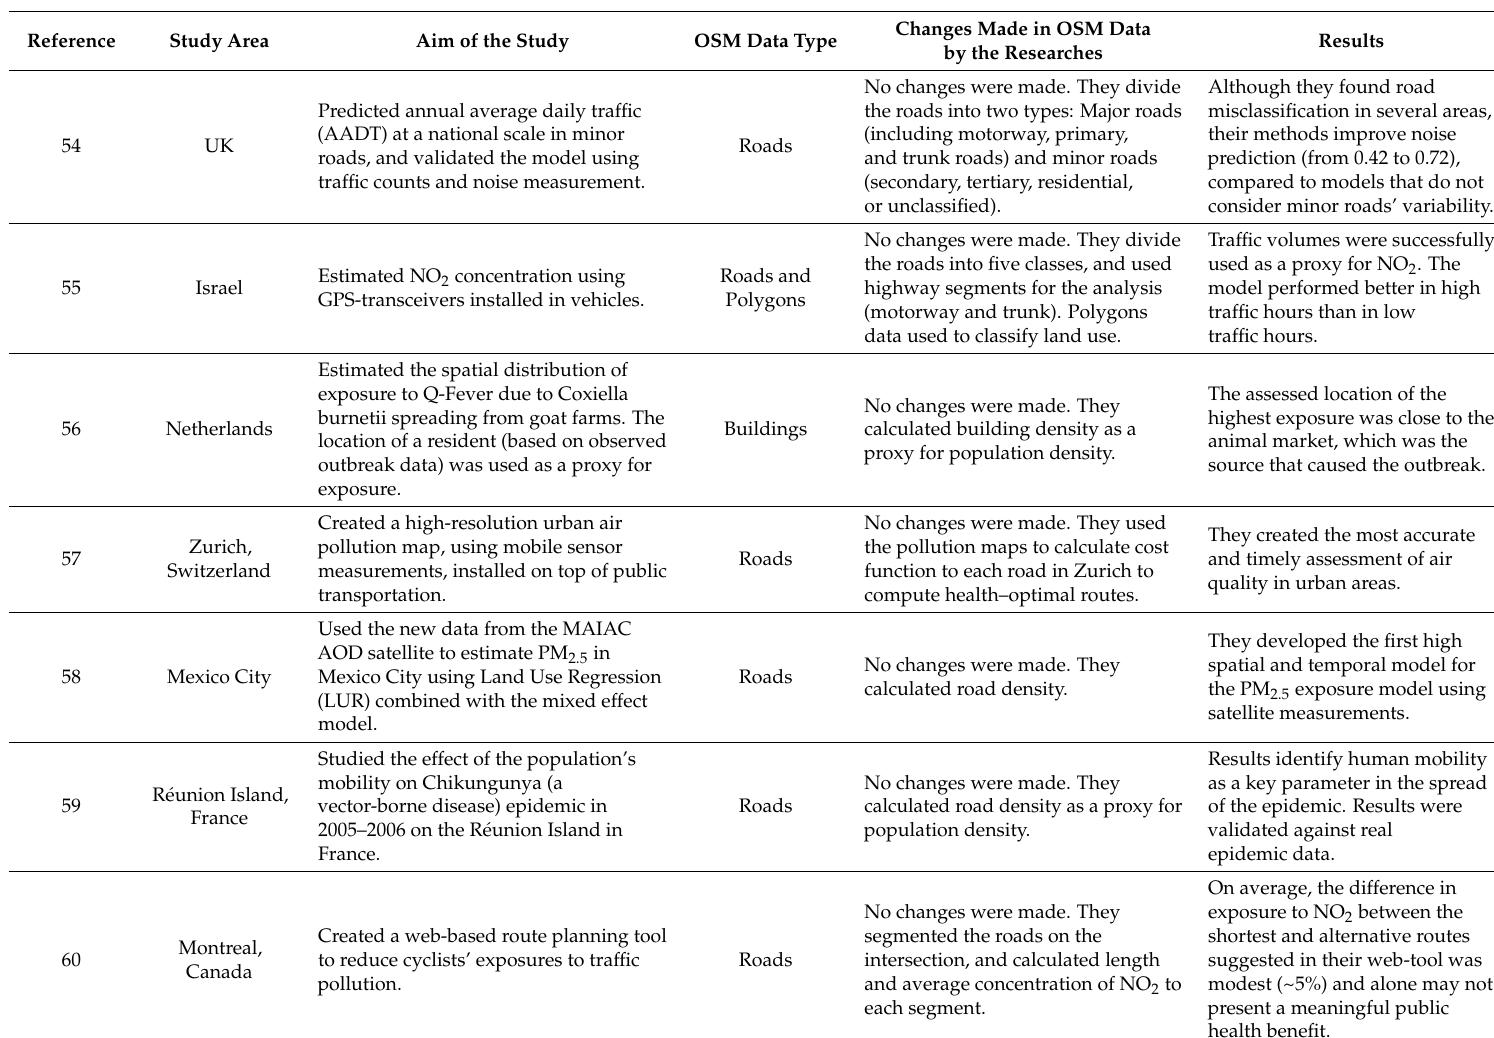
Table 1. Environmental assessment and epidemiological studies using OpenStreetMap (OSM) data as source